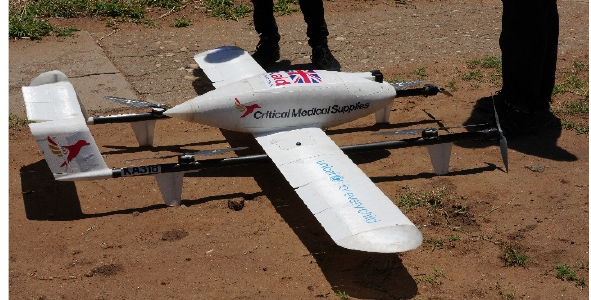
Figure 3. The VTOL UAV used by Swoop Aero in Nsanje.